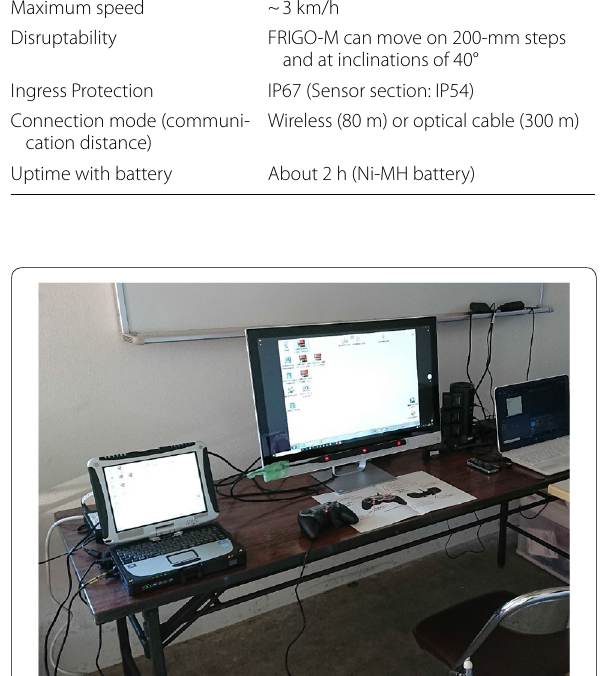
Fig. 5 Operator station for this